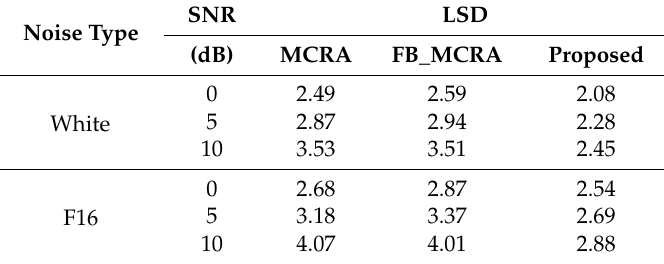
Table 3. Comparison of log spectral distance (LSD) for the denoised speech in various noise